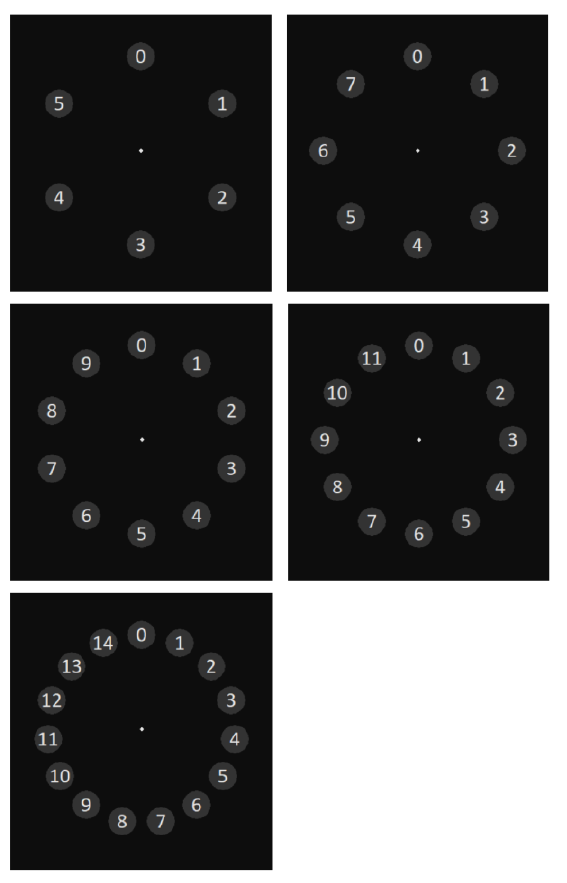
Figure 1: Interface layouts before outward movement of digits.